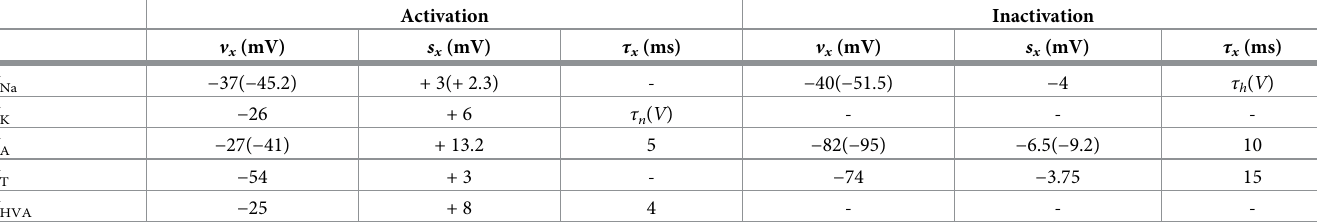
Table 1. Parameter values of the voltage-dependent ionic currents included in Eq (1). Whenever two values are provided for a single parameter, the first corresponds to pre-runup ( t = 0 min after patch clamping), while the second (between parentheses) corresponds to post-runup ( t = 25 min after patch clamping).